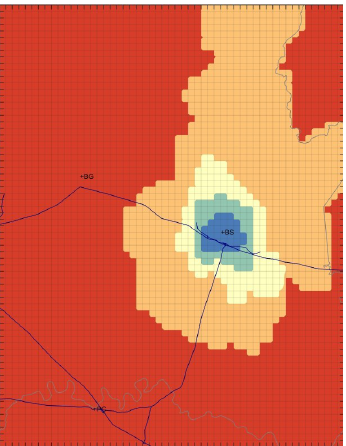
Figure 4. Application zone considered for the short term